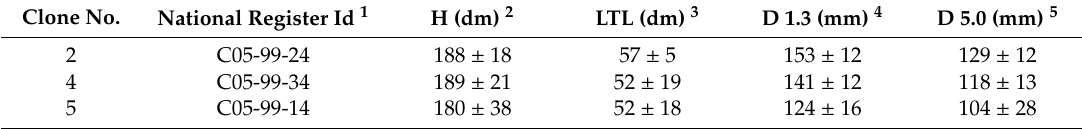
Table 1. Characteristics of the sample